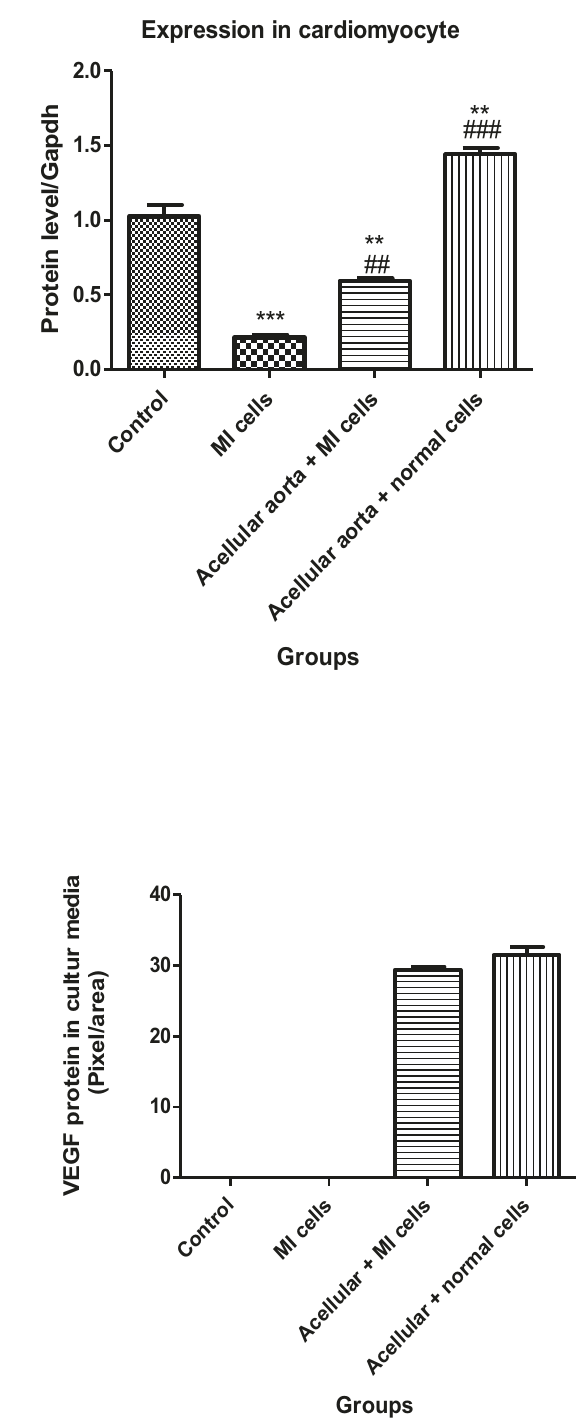
3D cultures. Control/Healthy cell: cardiomyocytes isolated from healthy NMRI mice. MI cell: cardiomyocytes isolated from myo- cardial infarction NMRI mice. The values are shown as the means and standard deviation of the mean (mean ± SD). * p < 0.05, ** p ≤ 0.01, and *** p ≤ 0.0001 shows the signi fi cant change in comparison to control ( p < 0.05). # shows the signi fi cant change in comparison to the MI group ( p <